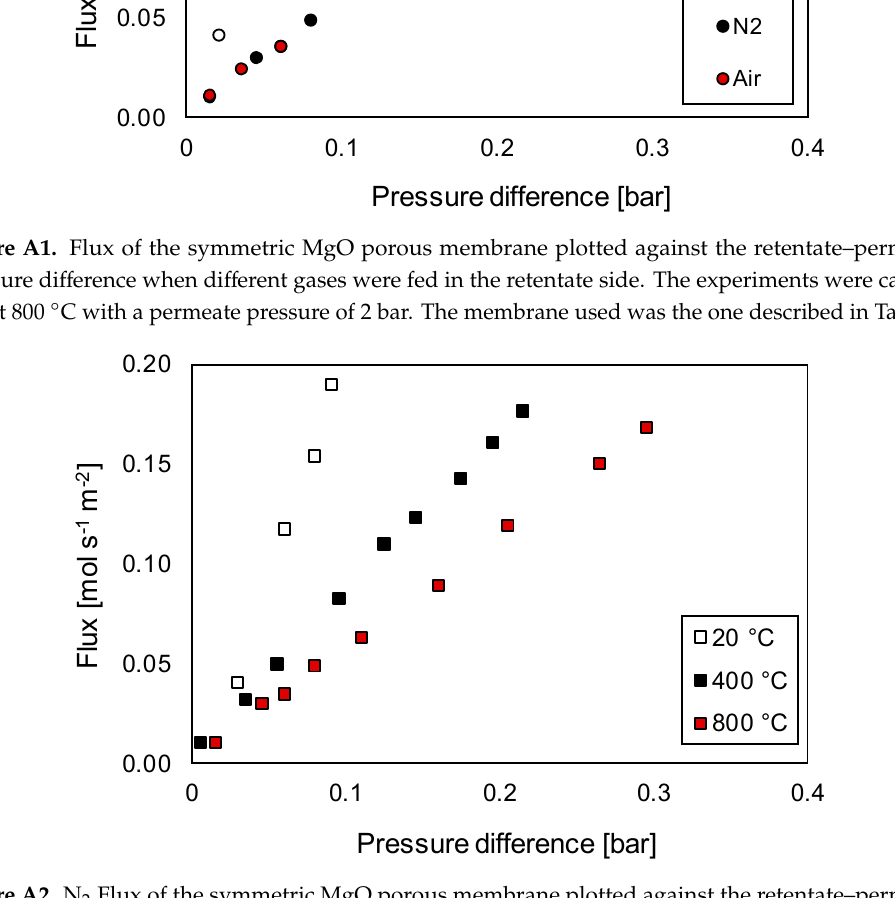
Figure A2. N 2 Flux of the symmetric MgO porous membrane plotted against the retentate–permeate pressure difference at different temperatures. The experiments were carried out with a permeate pressure of 2 bar and by feeding N 2 in the retentate side. The membrane used was the one described in Table 4.